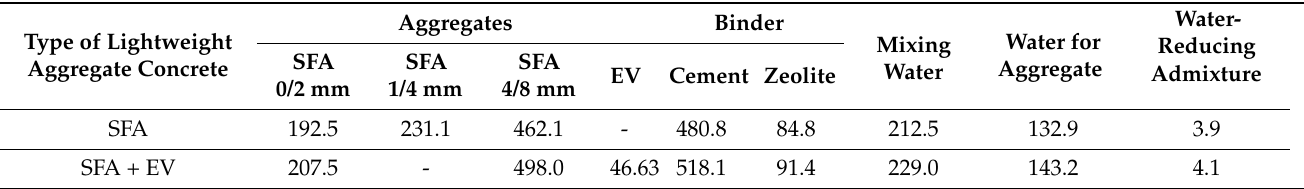
Table 2. Composition of concretes for 1 m 3 (kg/m 3